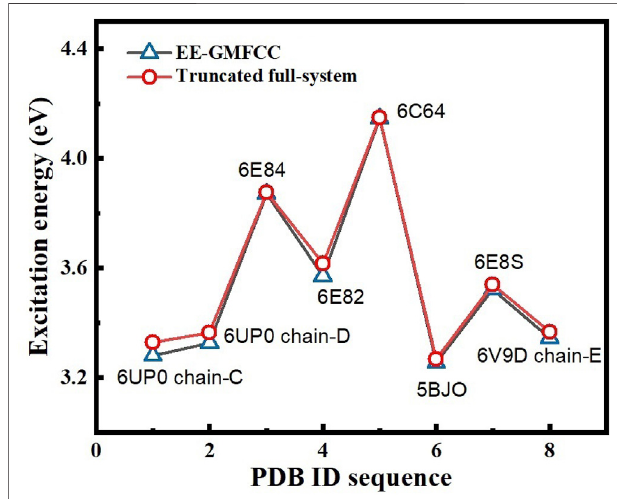
FIGURE 10 | Comparison of the excitation energies of eight different fl uorescent RNA systems between the EE-GMFCC approach and the truncated full-system calculations at the TD-HF/6-31G* level. The distance threshold λ 2B was set to 4.0 Å for the two-body QM calculations in the EE-GMFCC method. λ FS was set to 4 (cid:1) A for the truncated full-system approach.